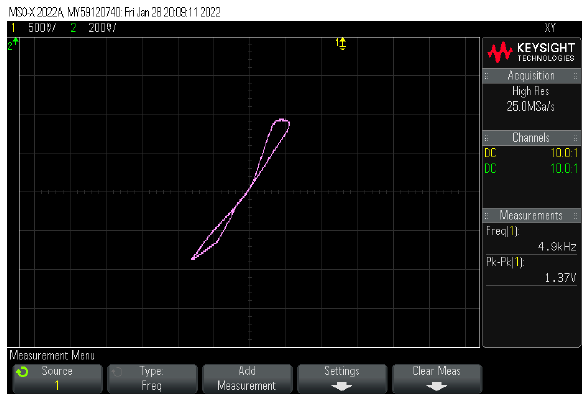
Figure 19. The experimental output of the proposed memristor at 5 kHz.